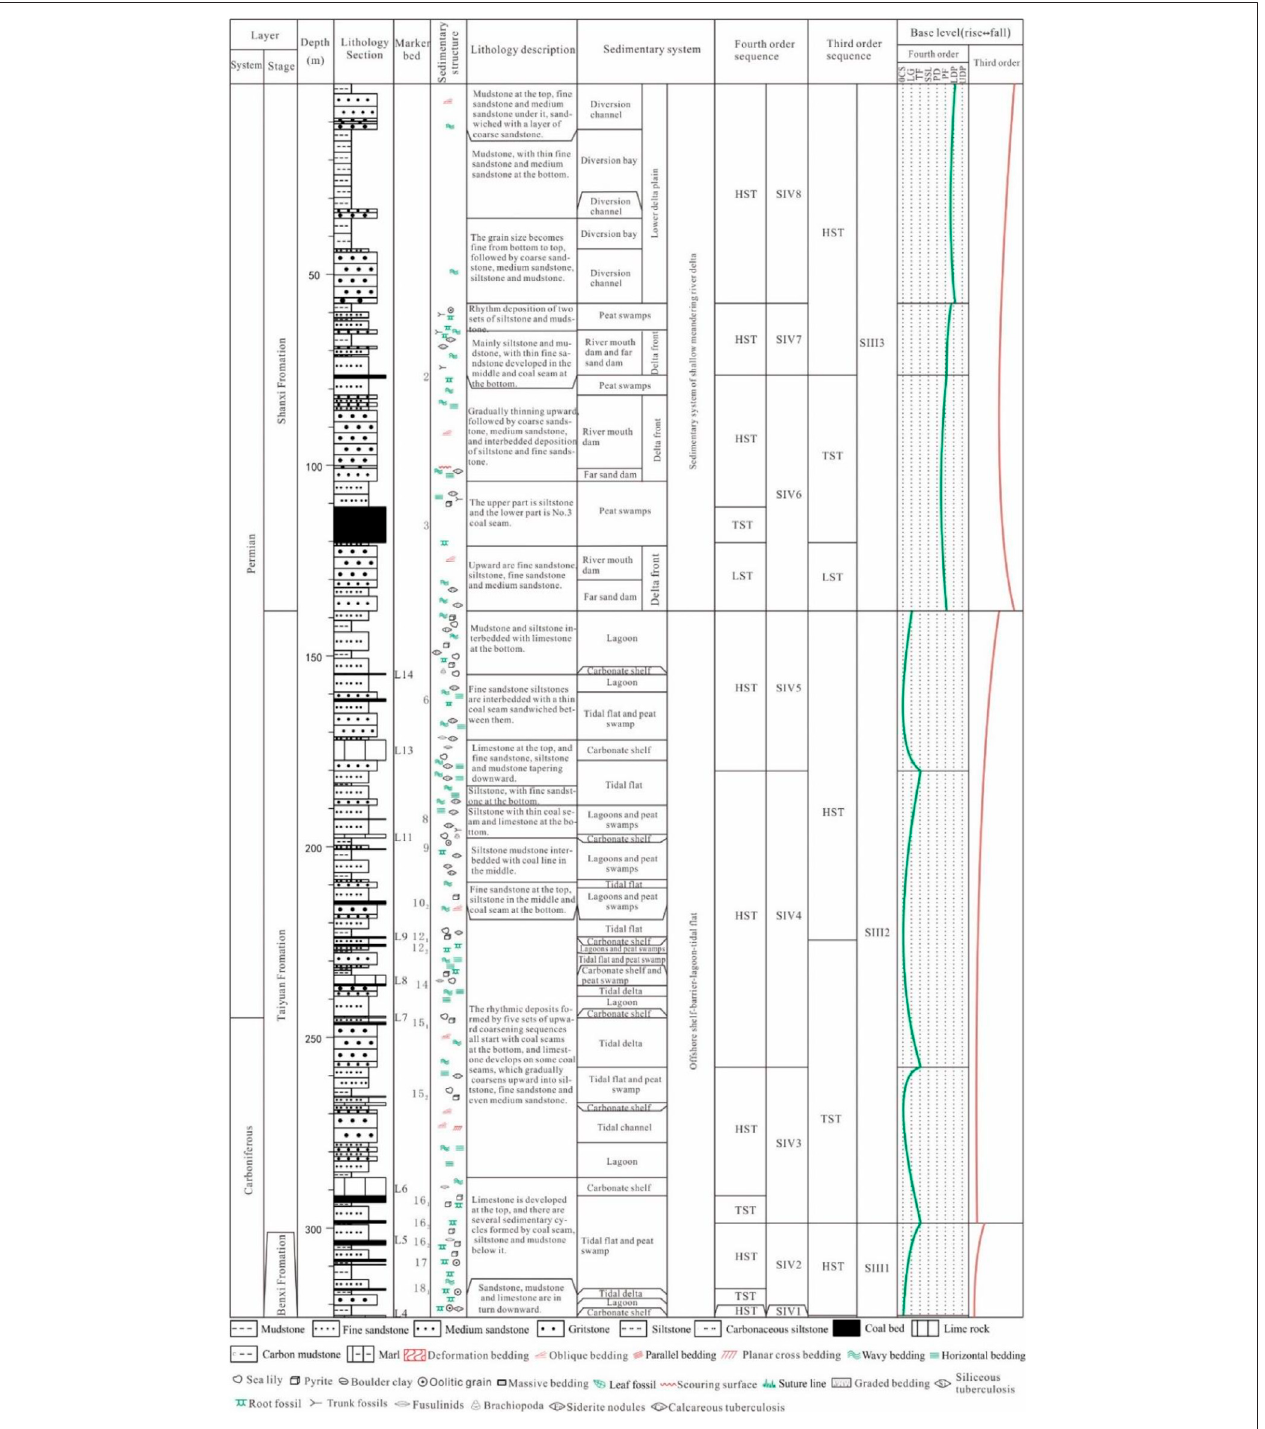
FIGURE 2 | Well XLZ-47: Comprehensive histogram of the sedimentary facies and sequence stratigraphy of the Carboniferous-Permian coal-bearing series.